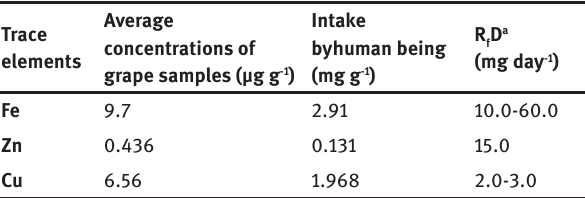
Table 6: Estimated daily intake of metal (DIM) through fruits. Average Trace concentrations of elements grape samples (µg g -1 )